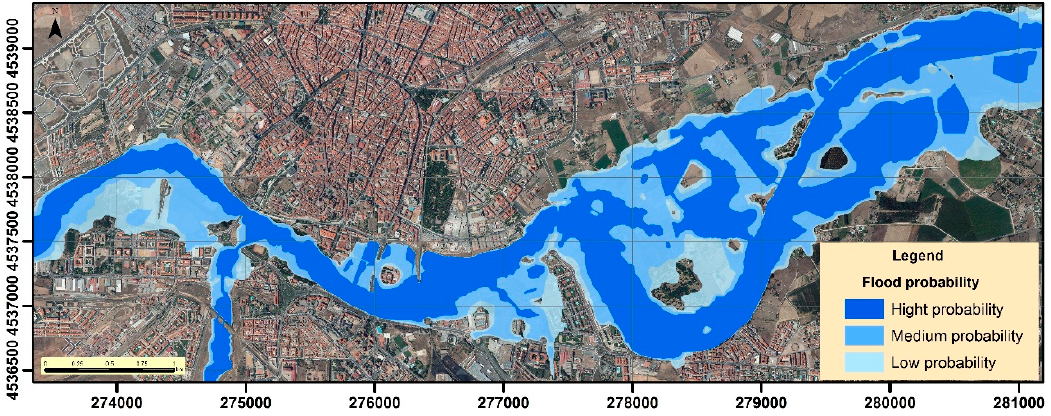
Figure 4. Flood probability of the areas surrounding the river.